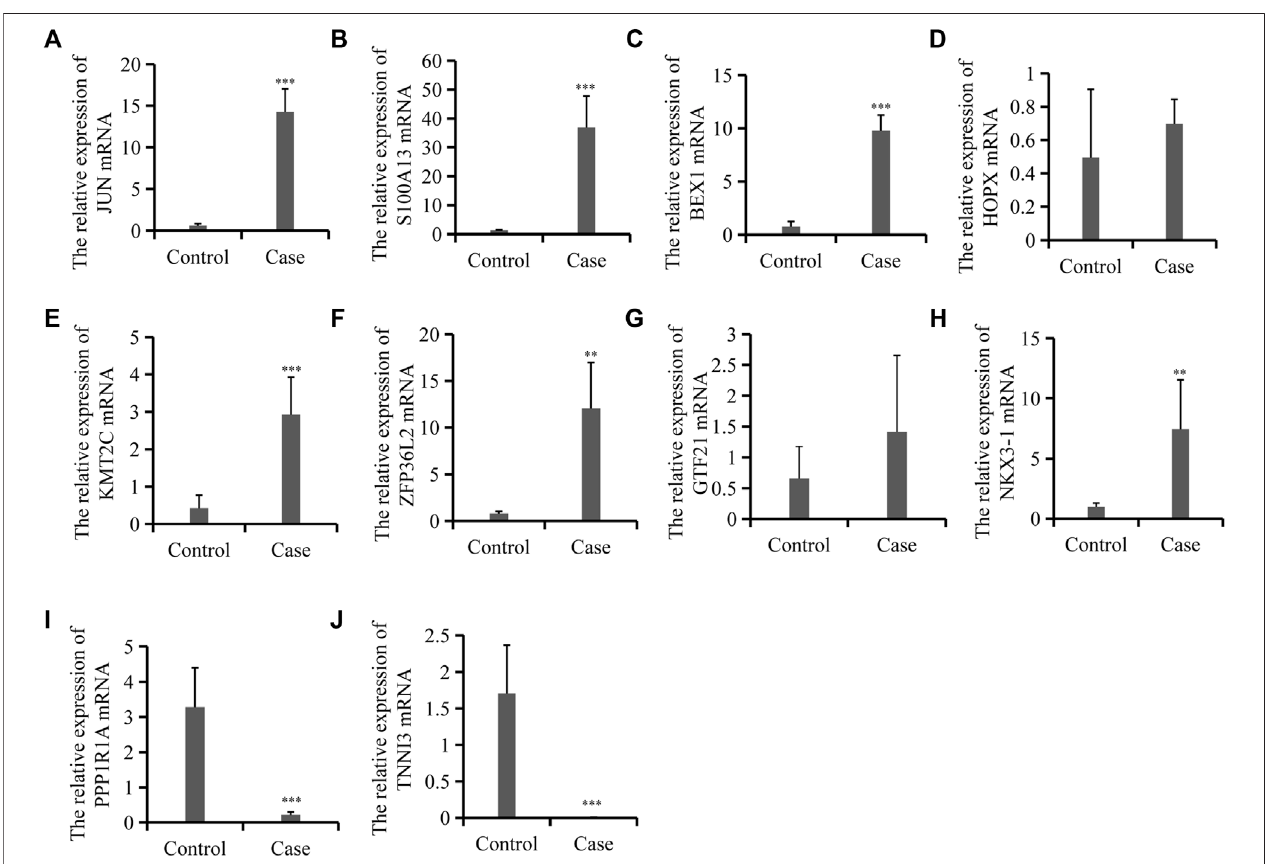
FIGURE3| Expressionvalidationfor10differentiallyexpressed mRNAsbetweenthecontrolandcasesgroup. (A – J) .RelativemRNAlevelsofJUN,S100A13, and BEX1 et al. as indicated by qRT-PCR. Data are mean ± SD ( n = 3); * p < 0.05, ** p < 0.01, *** p < 0.001.